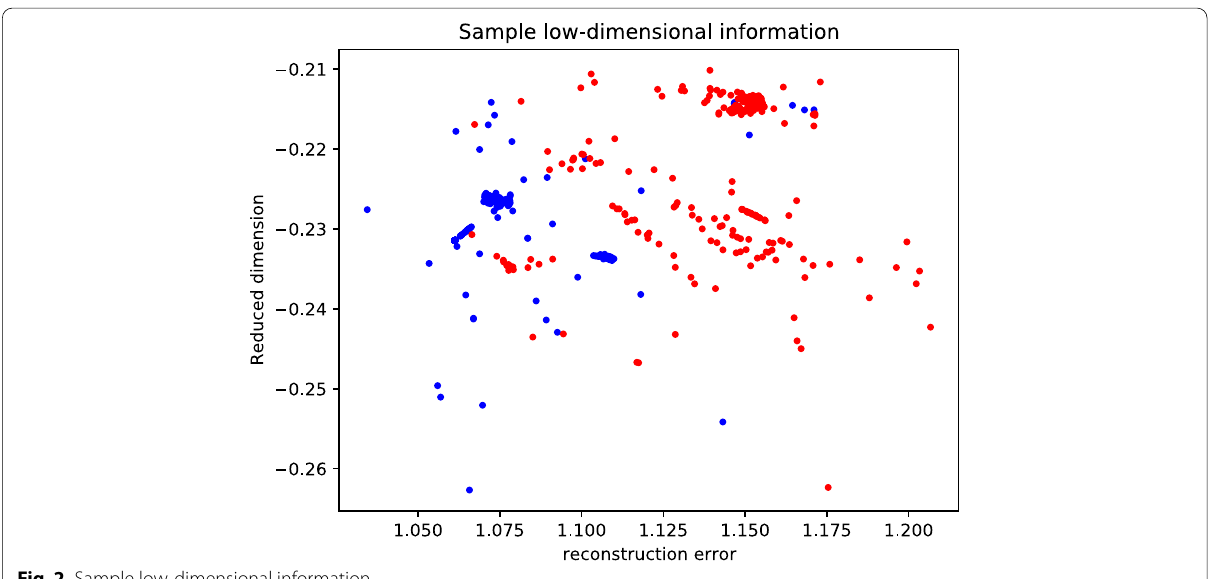
Fig. 2 Sample low-dimensional